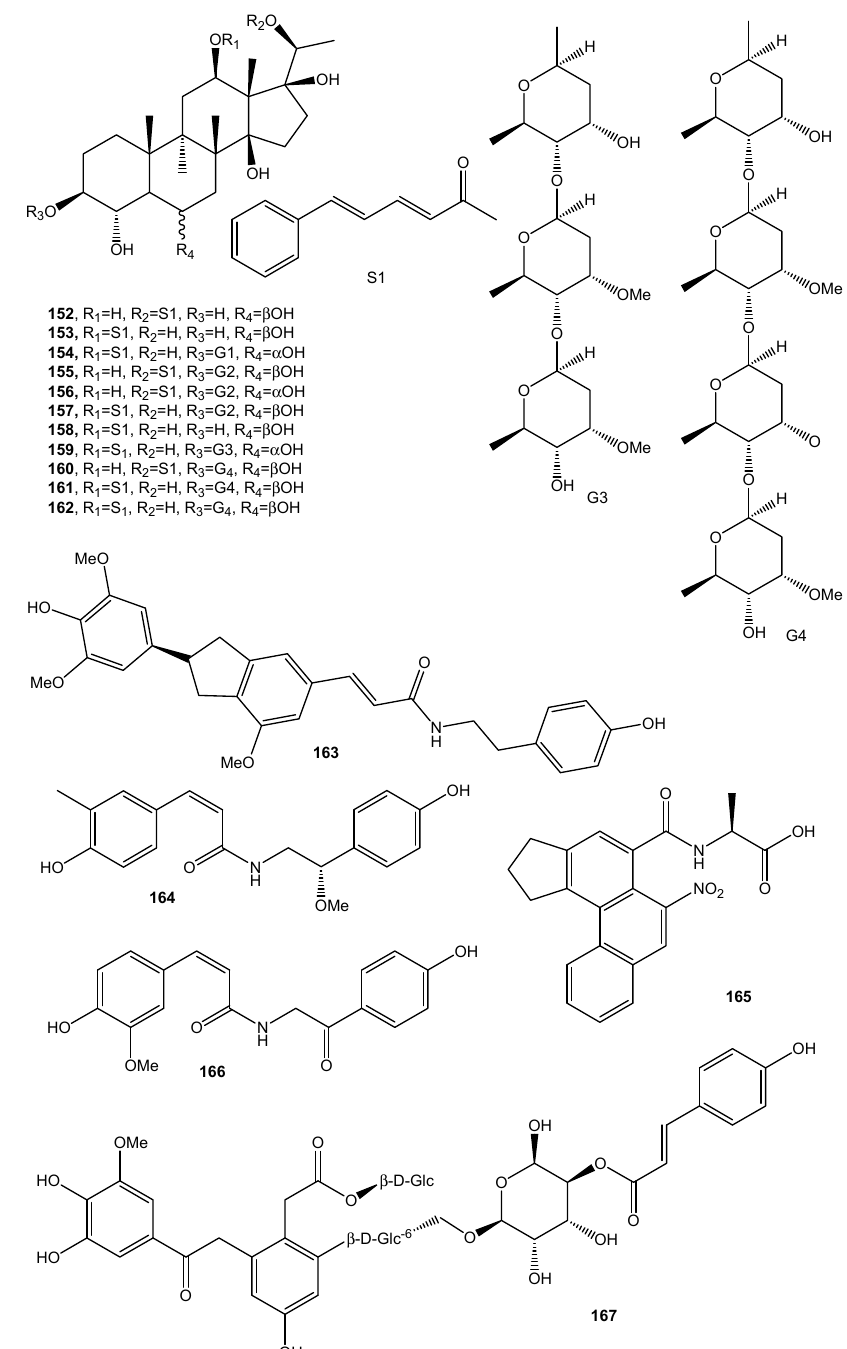
of the endocrine system, chapped skin, warts, arthritis and neuralgia [120].